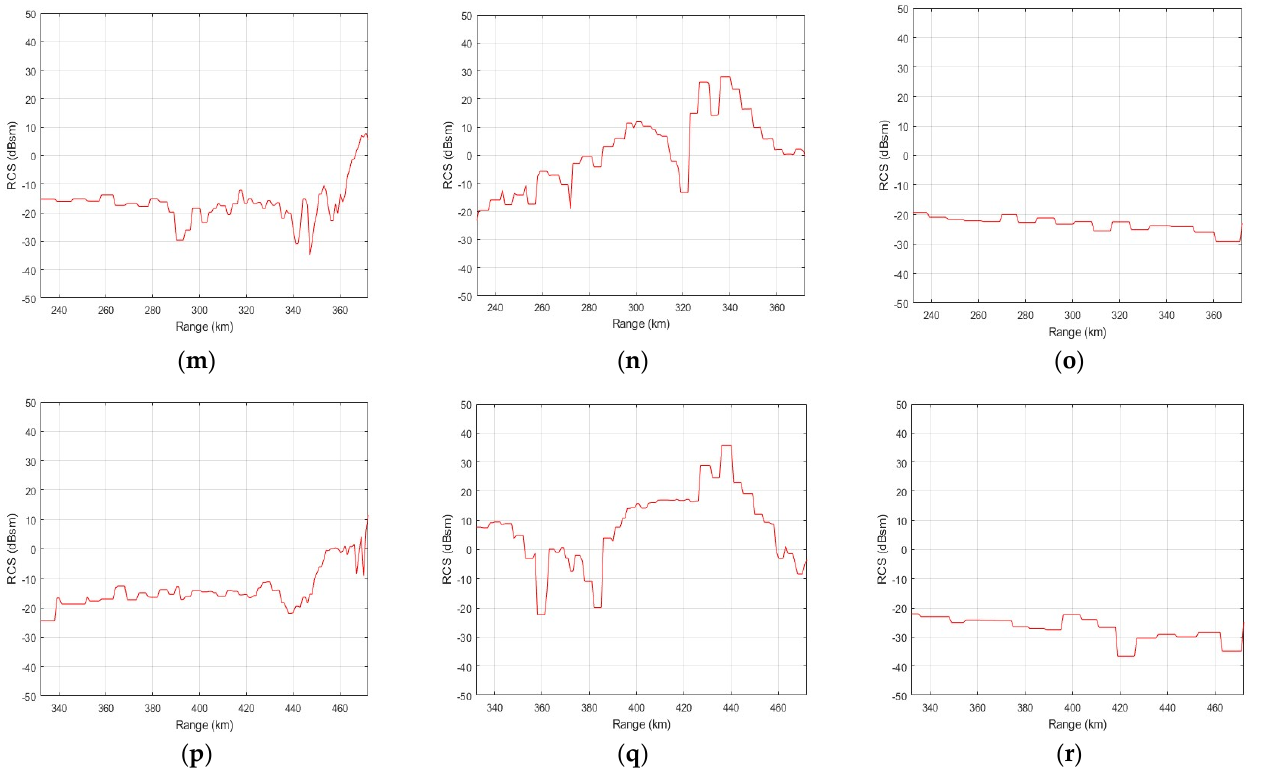
Figure 4. The original dynamic RCS graph according to the frequency for classes 1–6: ( a ) 1 GHz of class 1; ( b ) 3 GHz of class 1; ( c ) 10 GHz of class 1; ( d ) 1 GHz of class 2; ( e ) 3 GHz of class 2; ( f ) 10 GHz of class 2; ( g ) 1 GHz of class 3; ( h ) 3 GHz of class 3; ( i ) 10 GHz of class 3; ( j ) 1 GHz of class 4; ( k ) 3 GHz of class 4; ( l ) 10 GHz of class 4; ( m ) 1 GHz of class 5; ( n ) 3 GHz of class 5; ( o ) 10 GHz of class 5; ( p ) 1 GHz of class 6; ( q ) 3 GHz of class 6; ( r ) 10 GHz of class 6.